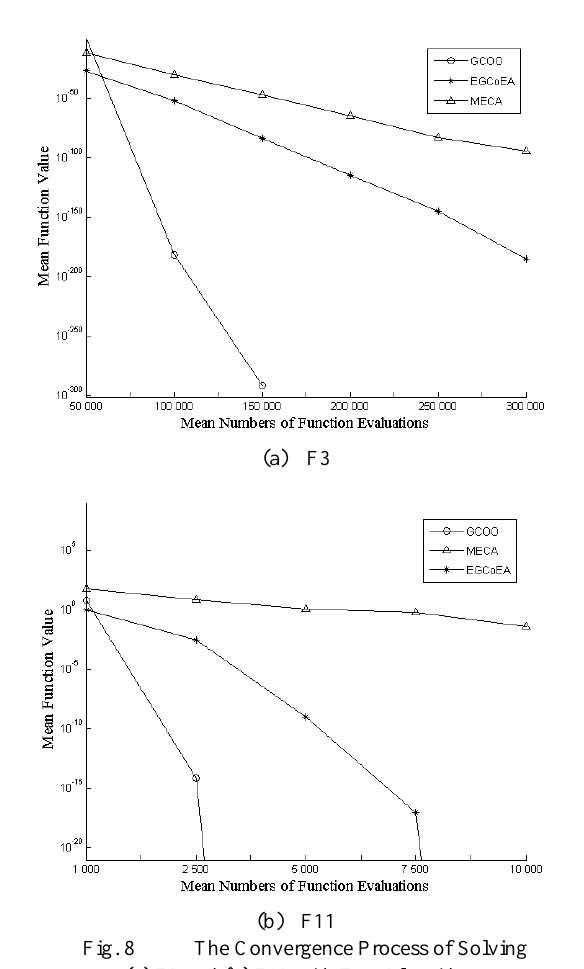
The Convergence Process of Solving (a) F3 and (b) F11 with Two